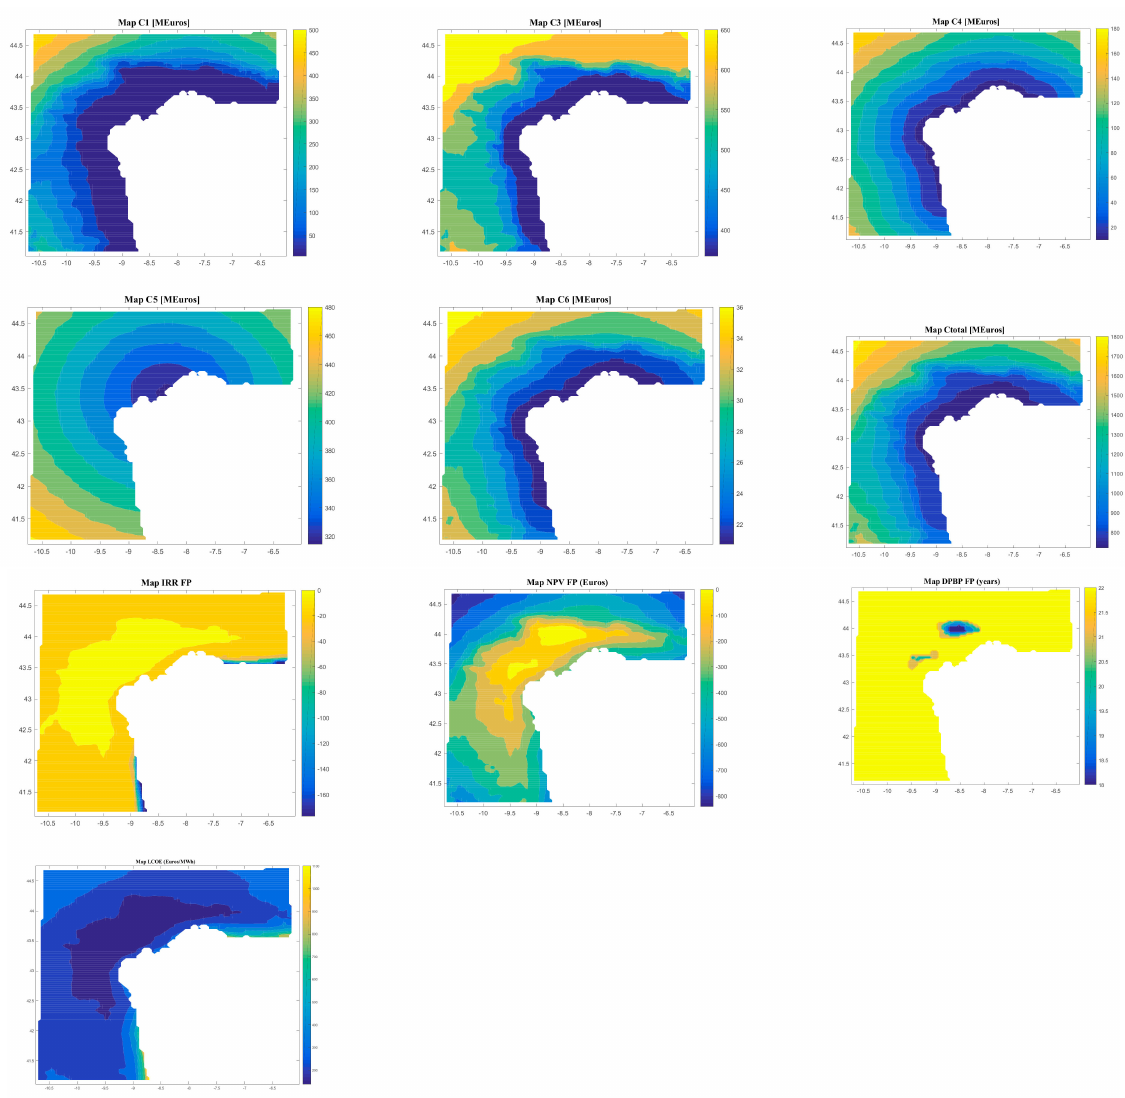
Figure 9. Results (C1, C1, C3, C4, C5, C6, Ctotal, LCOE, DPBP, IRR, NPV) for Case